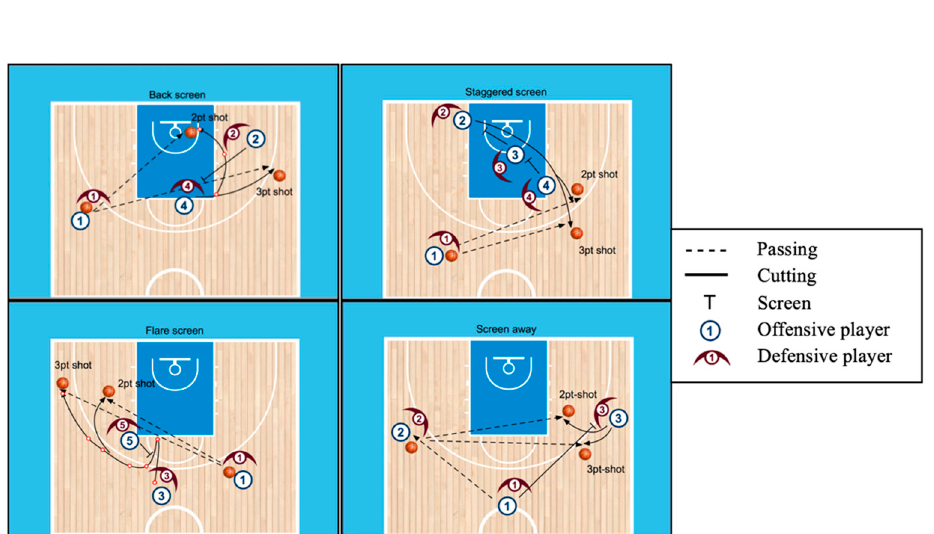
Figure 1. Execution of indicative offensive screens, back screens ( top left ), staggered screens ( top right ), flare screens ( bottom left ) and screen away ( bottom right ).